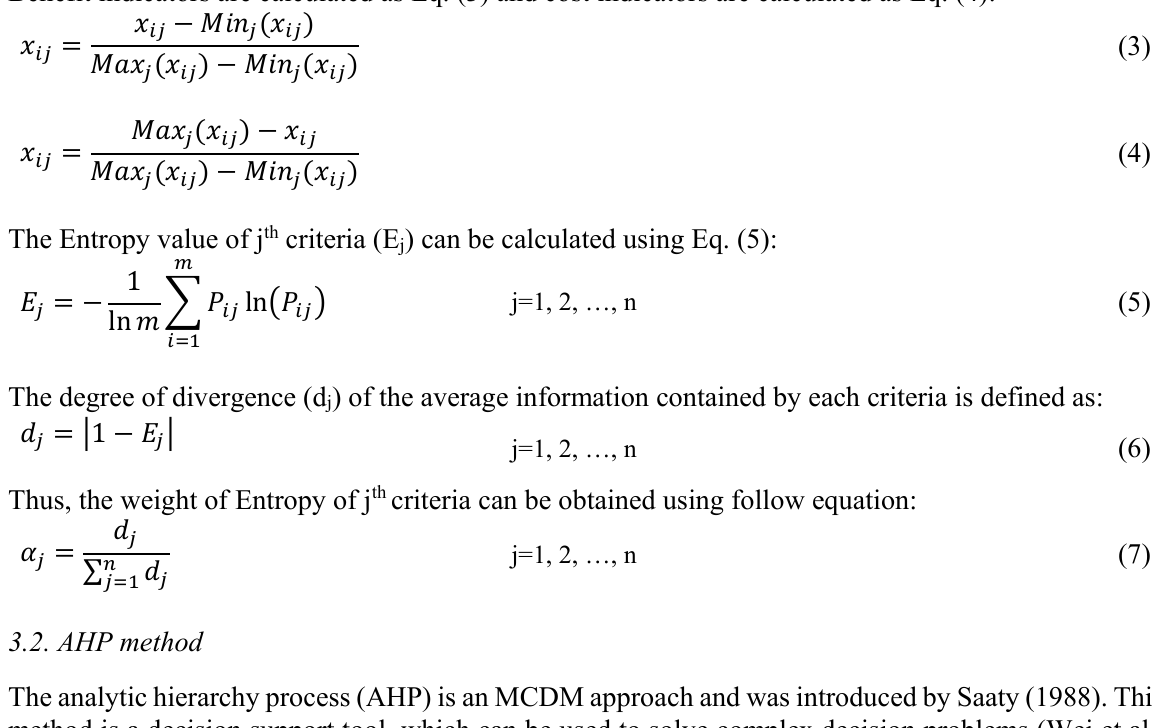
Benefit indicators are calculated as Eq. (3) and cost indicators are calculated as Eq.